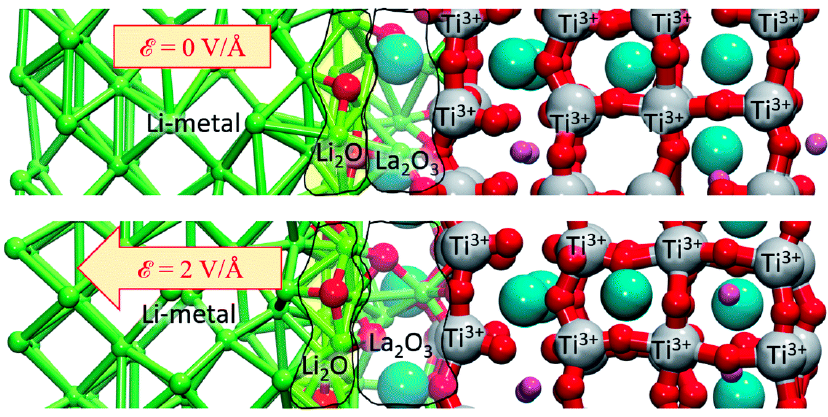
Figure 10. Structures of both oxides at 10 ps (atomic Bader charges) with and without the application of an external electric field [83].